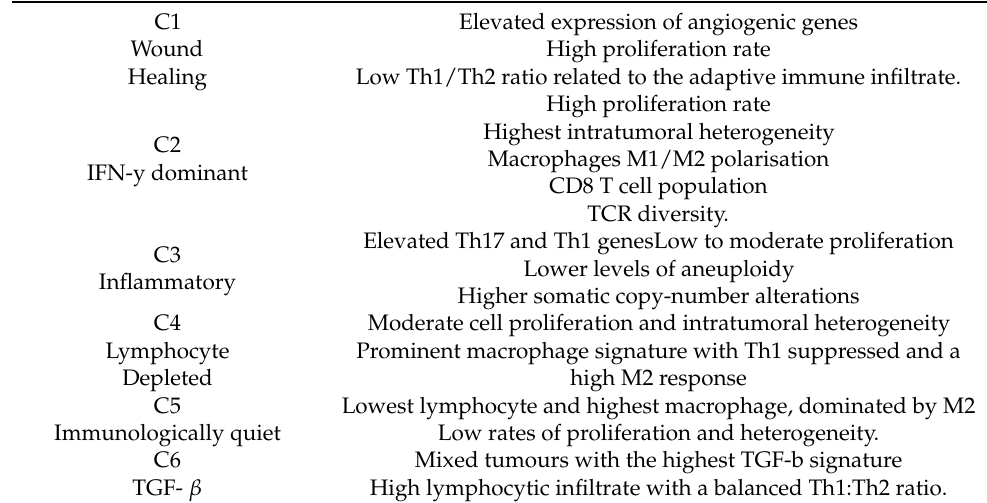
Table 1. Thorsson et al.: global immune classification of solid tumours based on the transcriptomic profiles. Th1/Th2, lymphocyte T helper 1/2; TCR, T cell receptor; Th17; lymphocyte T helper 17; IFN-y, interferon y; TGF- β , transforming growth factor β . Elevated expression of angiogenic genes C1 High proliferation rate Wound Low Th1/Th2 ratio related to the adaptive immune infiltrate. Healing High proliferation rate Highest intratumoral IFN-y dominant